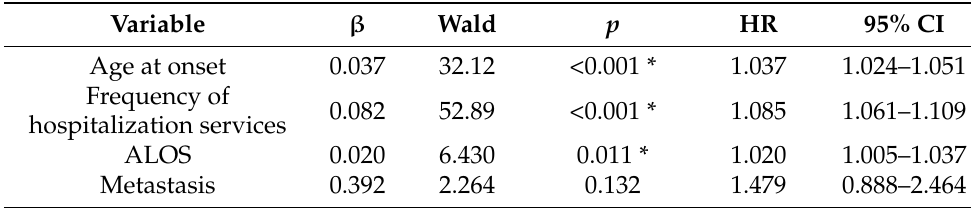
Table 3. Multivariate Cox proportional hazard model showing the variables associated with death from cervical cancer.